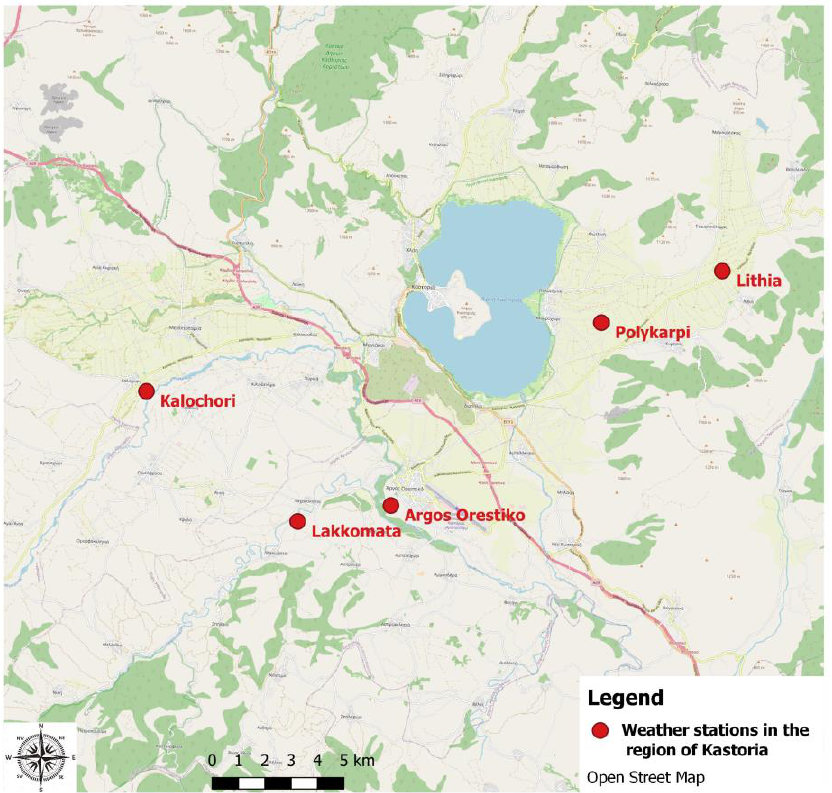
Figure 2. Distribution of the weather station in the region of Kastoria.